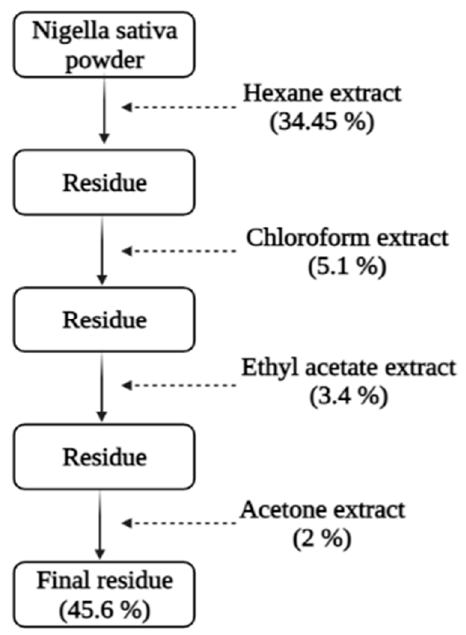
Figure 1. Successive extractions of N. sativa L. seeds. The hexane and acetone extracts were fractioned by column chromatography (6.5 cm × 47 cm) using high-purity grade silica gel column (pore size: 60 Å 63–200 µ m) at ambient temperature and standard pressure. The solvent eluents of hexane and ace- tone extract separation were dichloromethane and cyclohexane with (2/8) and (5/5) v / v ratios,